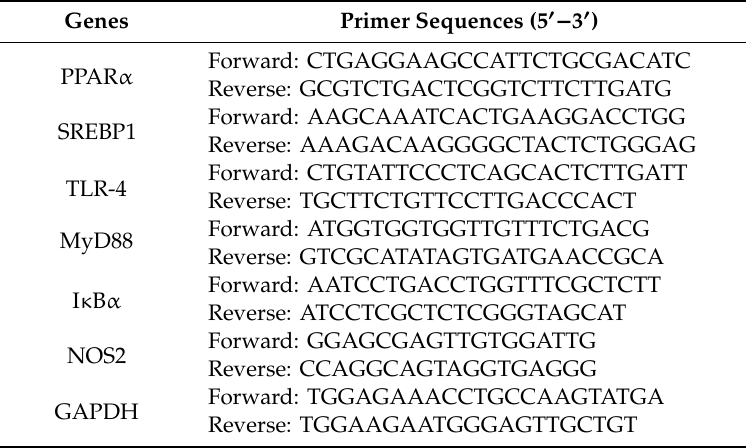
Table 1. Primer sequences used for